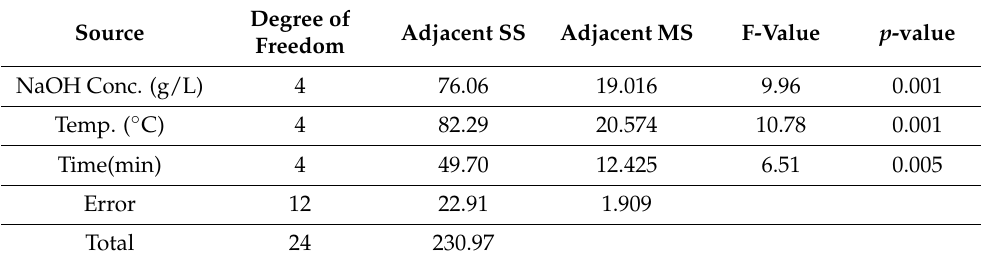
Table 5. ANOVA for NaOH solvent system parameters.